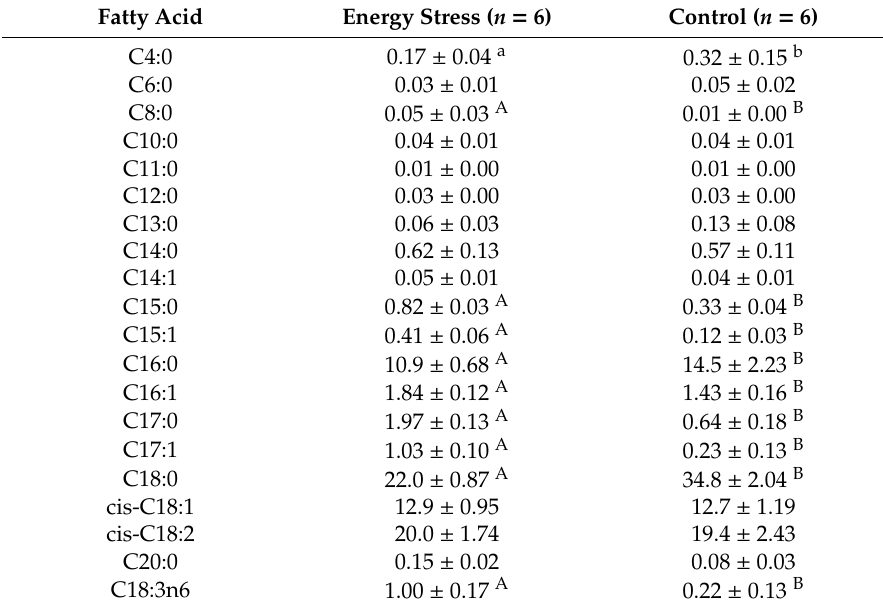
Table 2. Fatty acid composition (g / 100 g identified fatty acid) in the subcutaneous fat of the yaks in the energy stress (ES) group and control (CO)